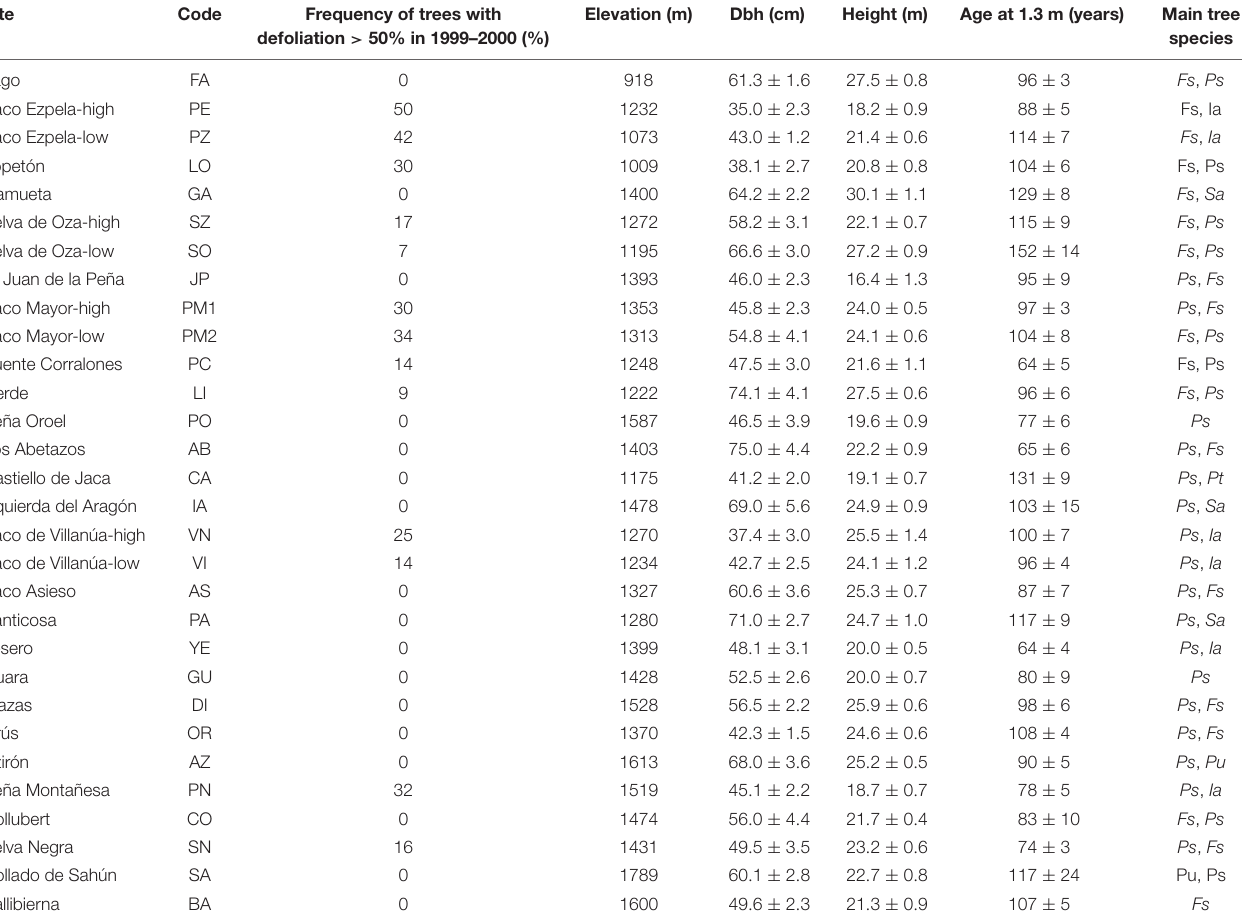
TABLE 1 | Characteristics of the studied silver fir stands. Site Code Frequency of trees with Elevation (m) Dbh (cm) Height (m) Age at 1.3 m (years) Main tree defoliation > 50% in 1999–2000 (%)